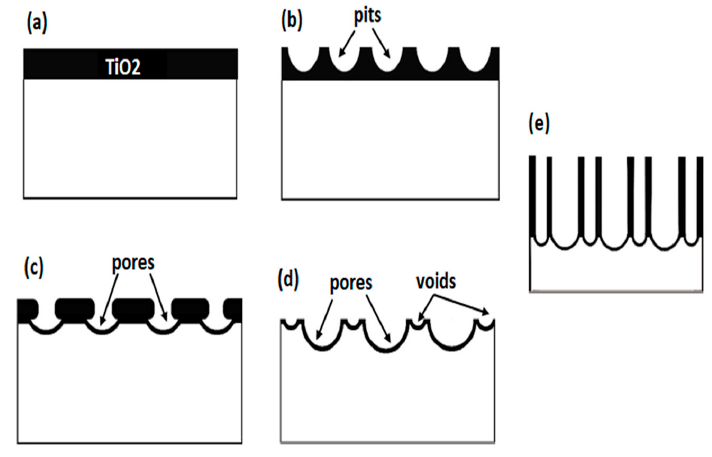
Figure 1. Formation mechanism of TiO 2 nanotubes ( a ) formation of TiO 2 compact layer ( b – d ) formation of cracks on the surface of the compact layer ( e ) steady growth of TiO2 nanotubes.